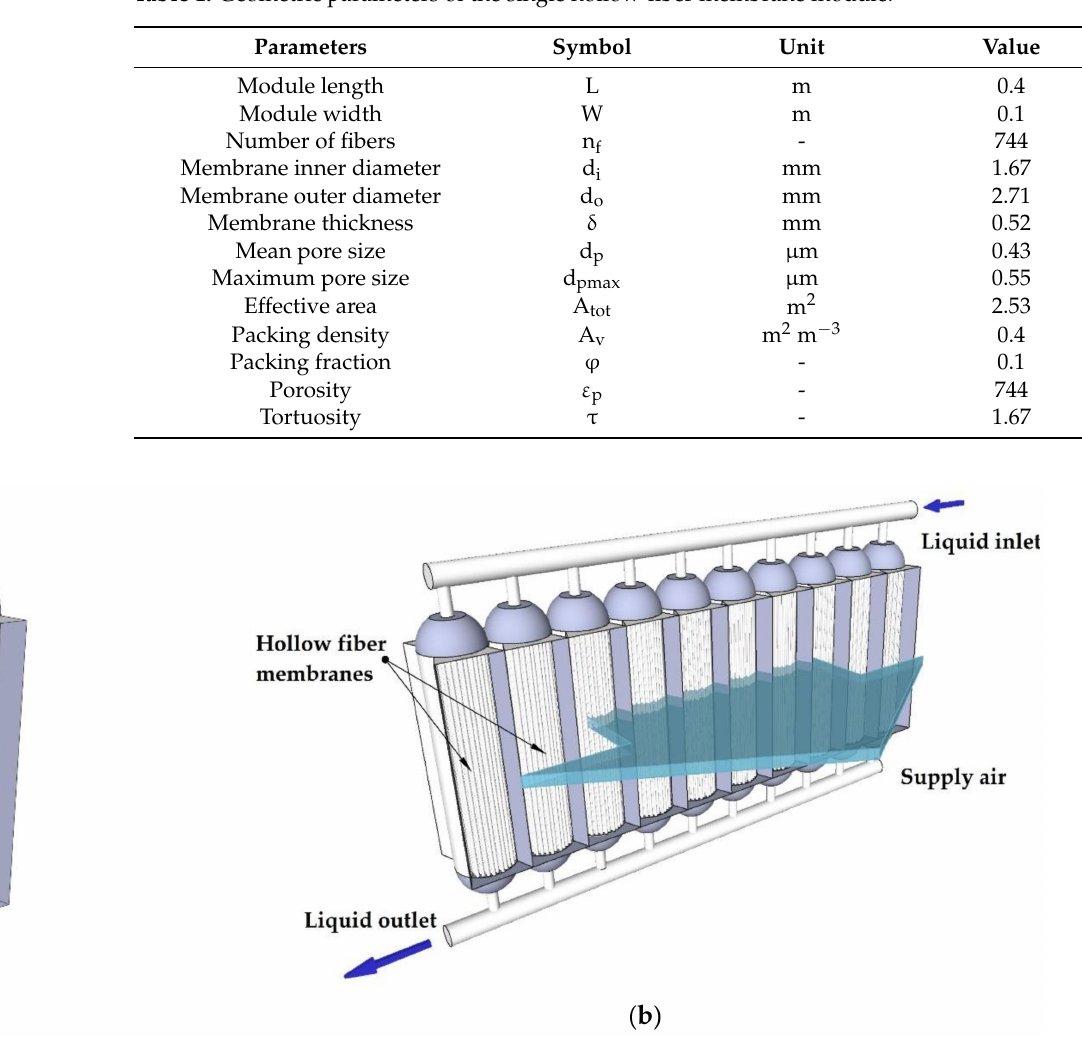
Figure 2. View of the membrane module for evaporative cooling or air dehumidification: ( a ) single hollow-fiber membrane module; ( b ) multimodule